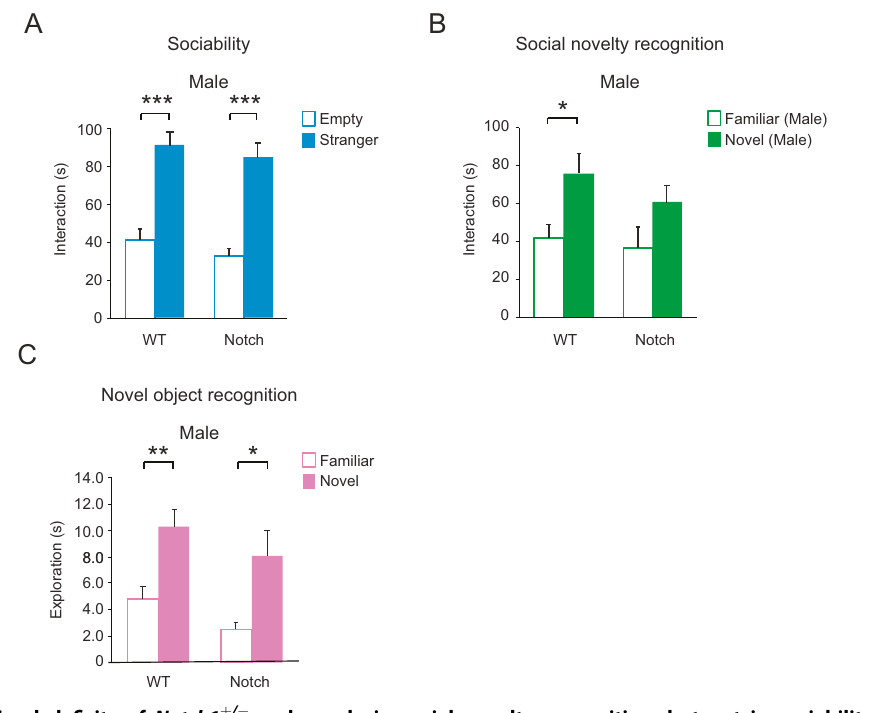
Fig. 1 Selective behavioral de fi cits of Notch1 + / − males only in social novelty recognition, but not in sociability. A Notch1 + / − males behaved normally in the sociability phase of the test, preferring to interact with a stranger male (solid bar). WT n = 8, Notch n = 9 B Notch1 + / − males did not show a signi fi cant preference for a novel male mouse (solid bar) over a familiar male mouse (open bar) in the social novelty recognition test. WT n = 8, Notch n = 9 C Notch1 + / − males showed normal novel object recognition 1 h after fi rst exposure. Both WT and Notch mice display a normal preference for a novel object (solid bars). WT n = 12, Notch n = 10 Two-way repeated measures analysis of variance (rmANOVA) with Bonferroni adjusted post-hoc analysis. Data are shown as mean ± SEM. * p < 0.05, ** p < 0.01, and *** p < 0.001.